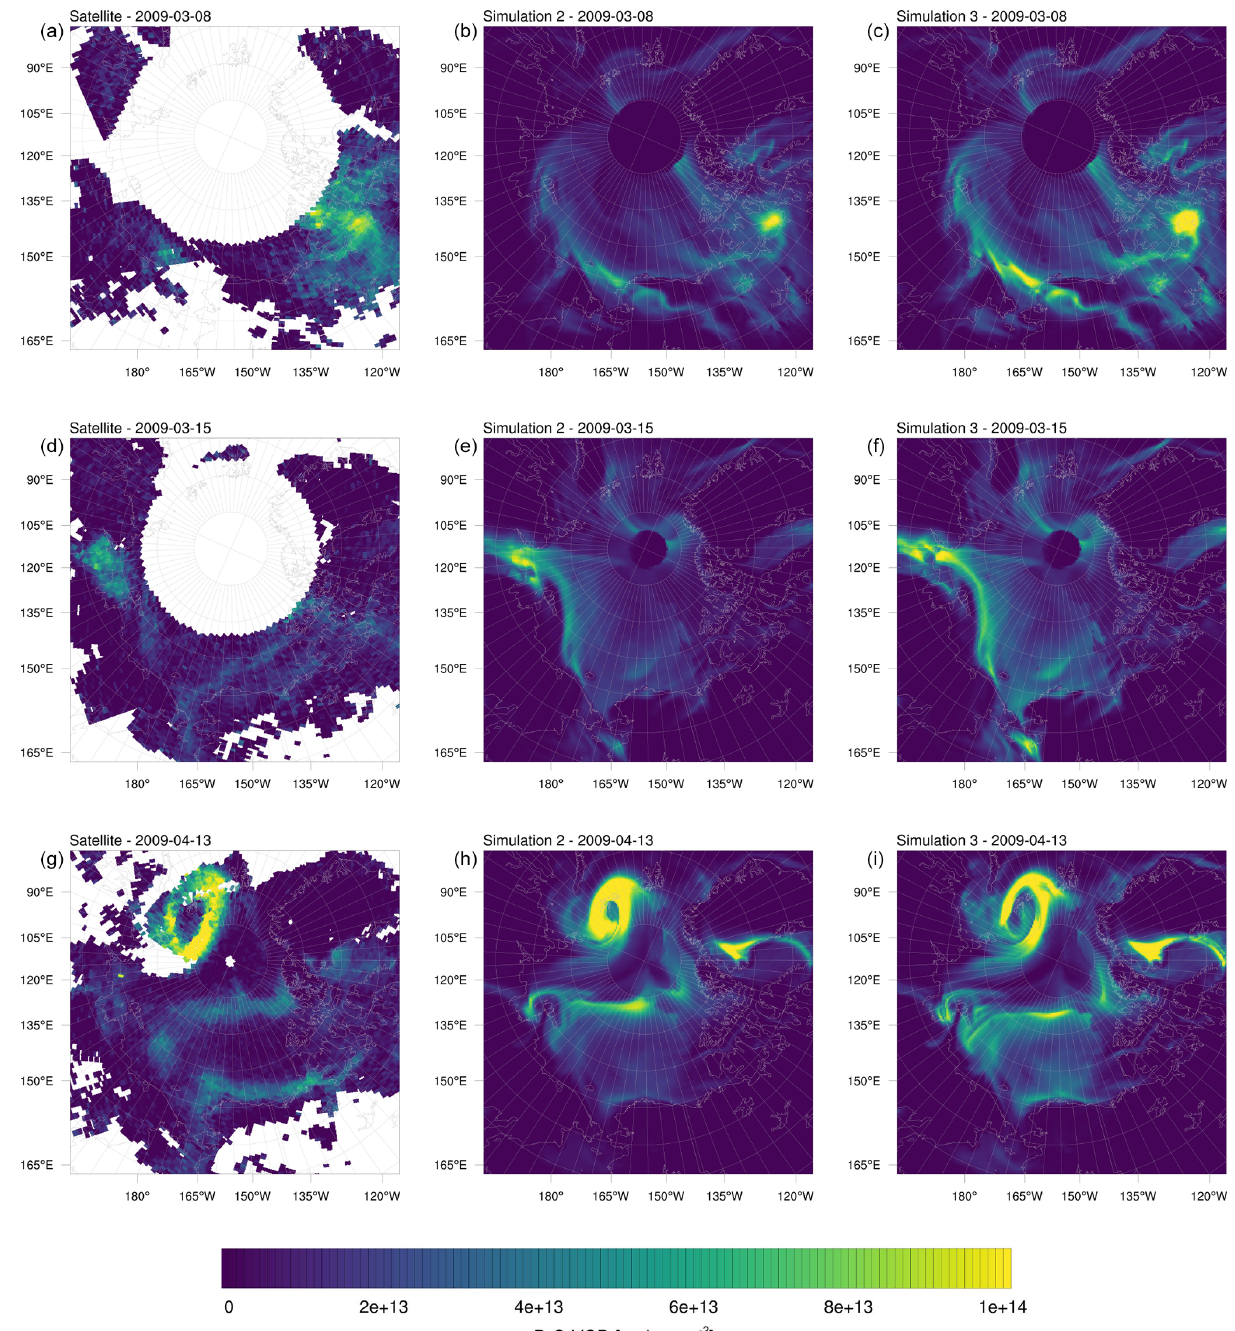
Figure 13. BrO VCDs on selected days in the year 2009. (a, d, g) Satellite measurements. (b, e, h) Simulation 2 ( β = 1 . 0). (c, f, i) Simula- tion 3 ( β = 1 .